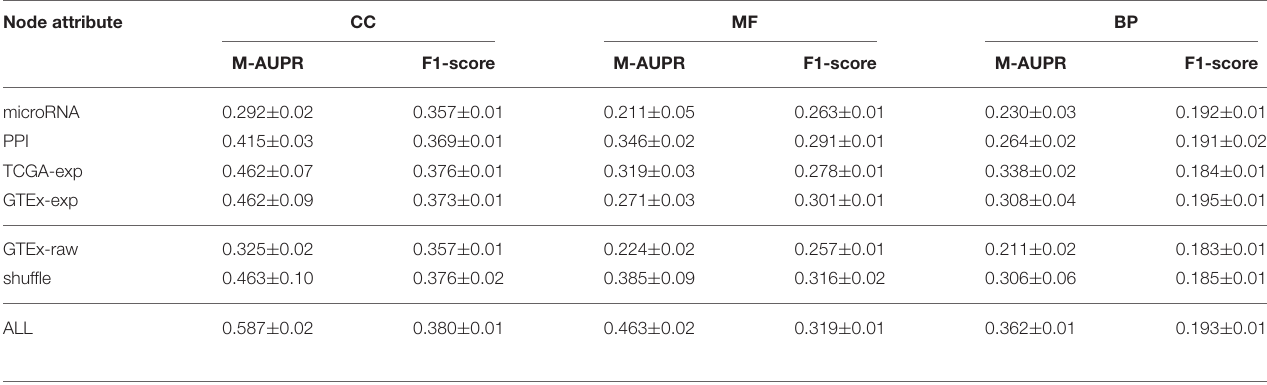
TABLE 1 | Comparison between different node